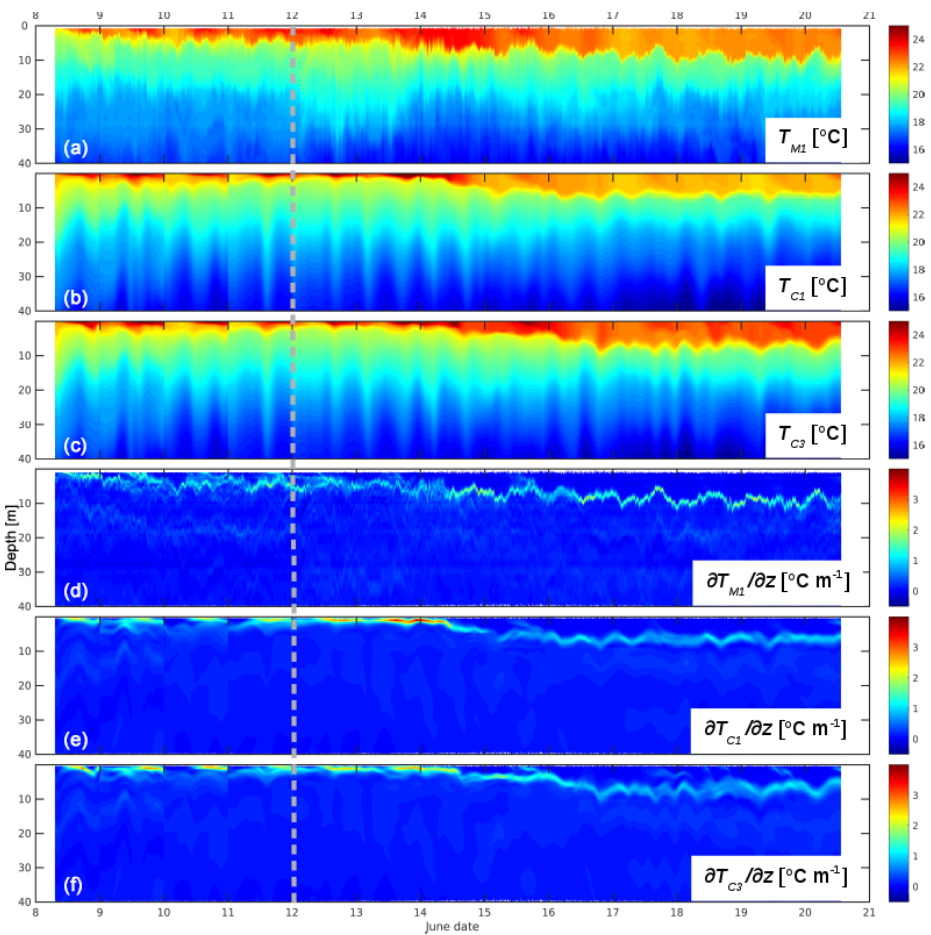
Figure 16. (a) The observed temperature at mooring M1, (b) the modelled temperature from ROMS runs C1 and (c) C3, (d) and the vertical temperature gradient from M1, (e) C1, and (f) C3. The instant of the last data assimilation is indicated by the the grey dashed vertical